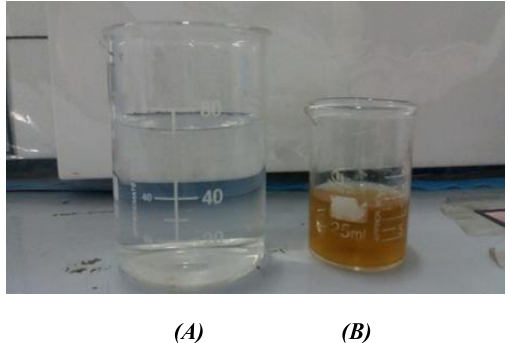
Fig. 2. UV–Vis spectra of synthesized AgNPs using coffee Fig2. UV – Vis spectra of synthesized AgNPs using coffee residues Fig. 1. The color change of the reaction solutions before the Fig1 . The color change of the reaction solutions before the production of silver (A) nanoparticles and residues production of silver (A) nanoparticles and after the production after the production of nanoparticles(B) of nanoparticles(B)